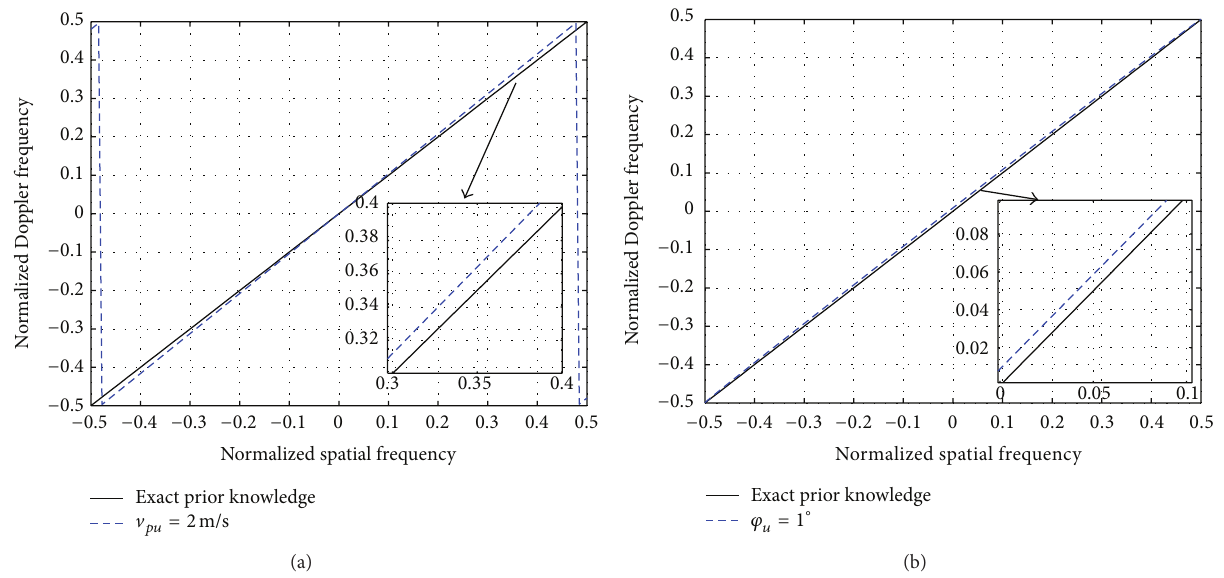
Figure 2: Impact of prior knowledge uncertainty to the clutter ridge in the spatiotemporal plane with (a) velocity deviation V 𝑝𝑢 = 2 m/s and (b) 𝜙 𝑢 = 1 ∘